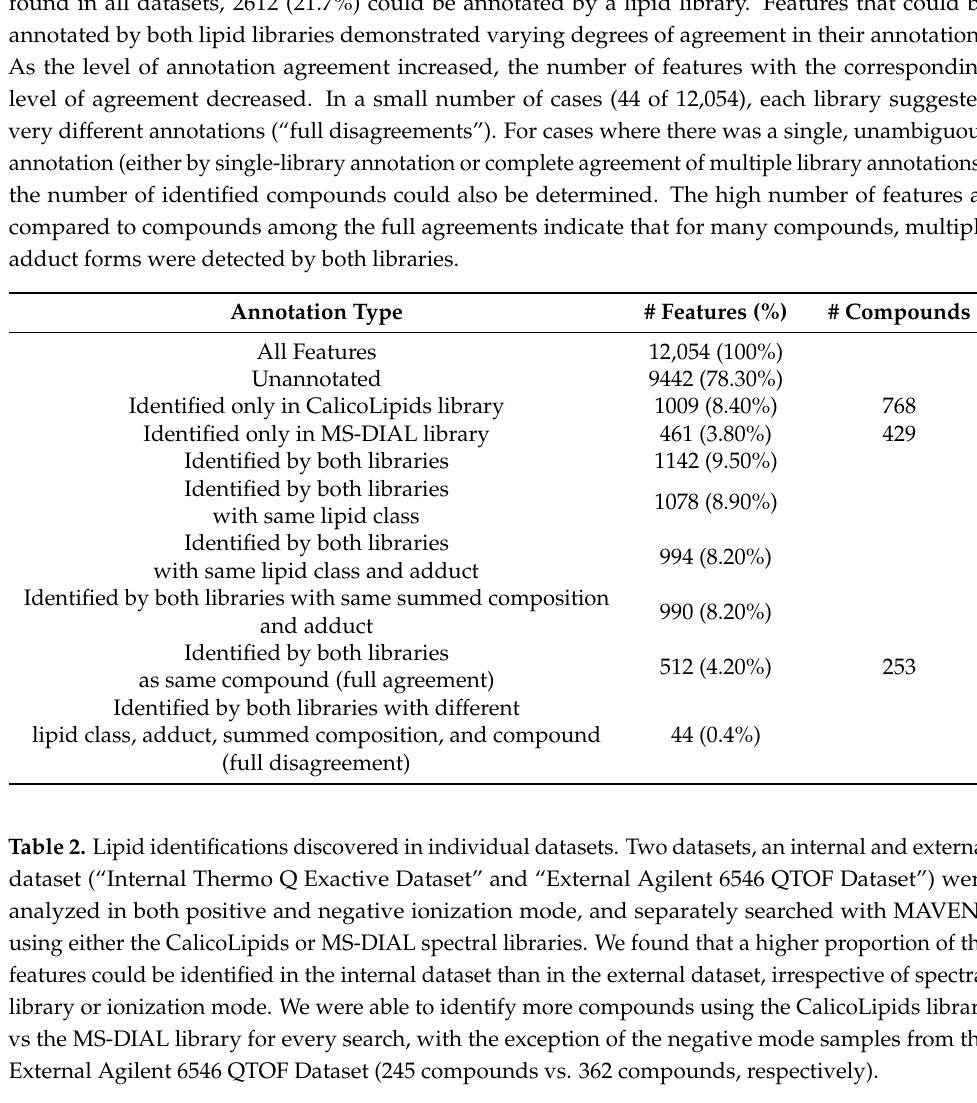
Table 1. Lipid annotation agreement across several lipid datasets. All features from all lipid datasets were searched against both the CalicoLipids and MS-DIAL lipid libraries. Among the 12,054 features found in all datasets, 2612 (21.7%) could be annotated by a lipid library. Features that could be